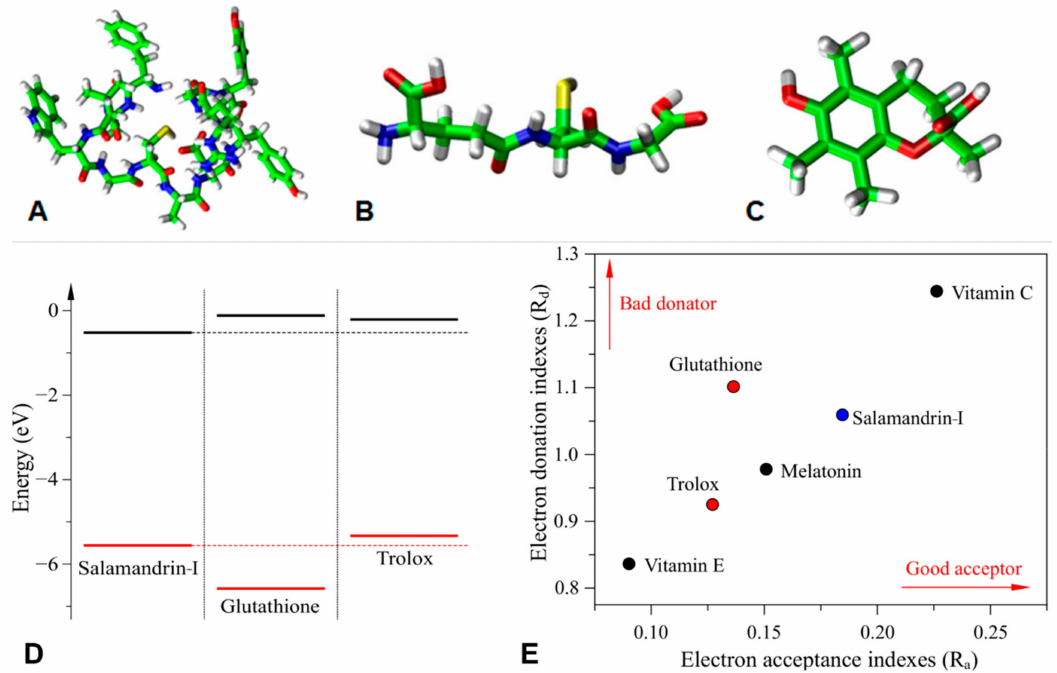
Figure 4. Density functional theory (DFT) optimized structures of ( A ) salamandrin-I, ( B ) glutathione, and ( C ) trolox. Atomic colors: C (green), O (red), S (yellow), N (blue) and H (white). ( D ) Frontier energy level alignments between salamandrin-I, glutathione, and Trolox (highest occupied molecular orbital (HOMO): red and lowest unoccupied molecular orbital (LUMO): black). ( E ) Donor-acceptor map for varied antioxidants. The reference values obtained for melatonin, vitamin E and vitamin C were obtained from